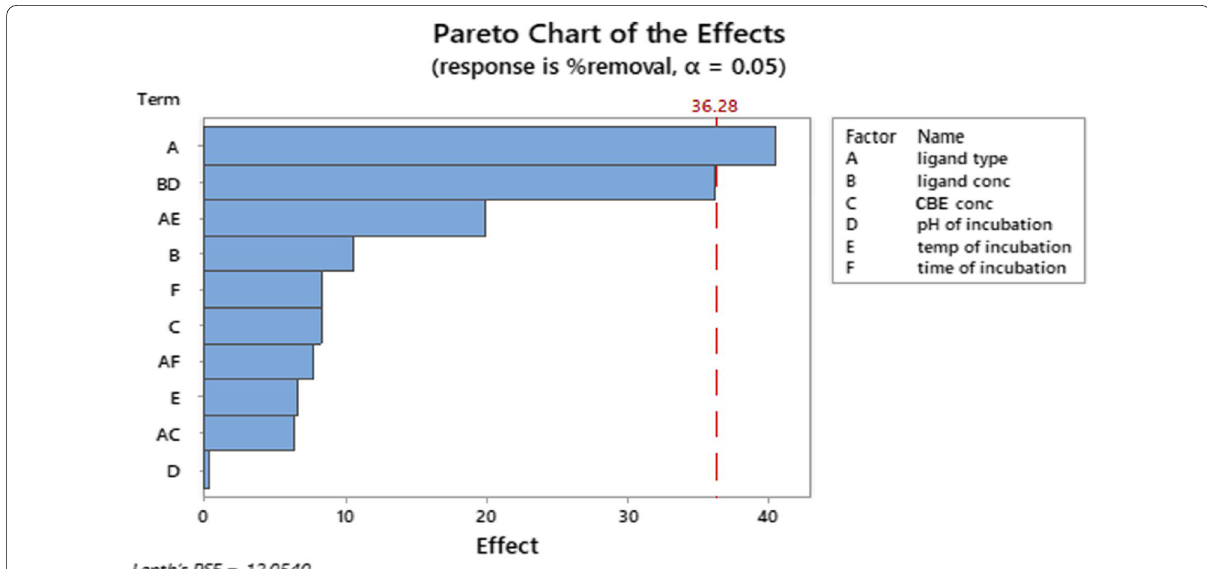
Fig. 7 Pareto chart of the fractional factorial design done by Minitab 2010, for investigation of factors affecting adsorption process which showed significance of the ligand type